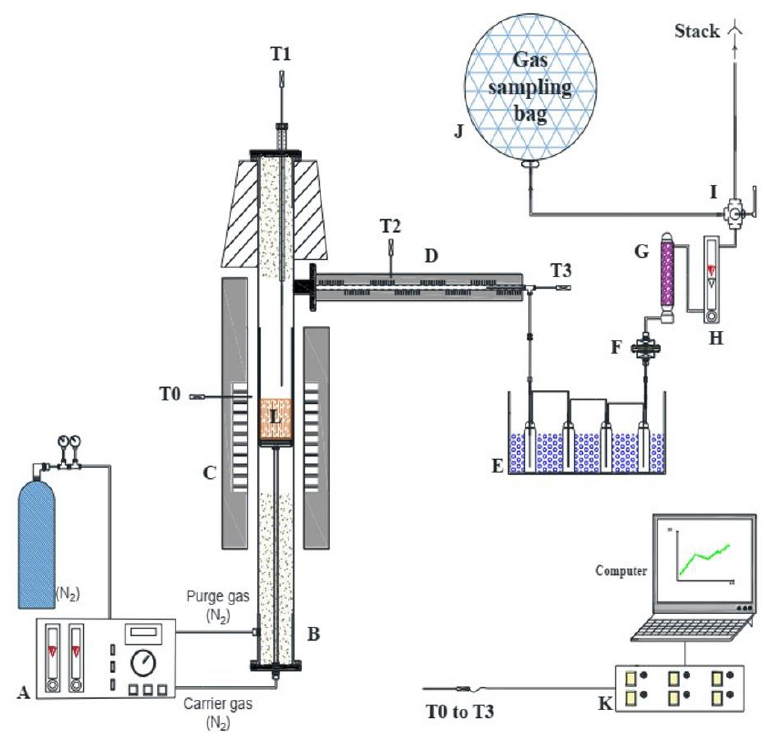
Figure 1. Layout of the fixed-bed pyrolysis facility. ( A ) Furnace temperature and carrier gas flow- rate control unit, ( B ) fixed bed reactor, ( C ) electrically heated reactor furnace, ( D ) electrically heated gas sampling line, ( E ) ice bath, ( F ) quartz filter, ( G ) silica gel tower, ( H ) gas flowmeter, ( I ) three-way ball valve, ( J ) gas sampling bag, ( K ) data acquisition and control system, ( L ) cylindrical wood particle; T0 to T3 — K-type